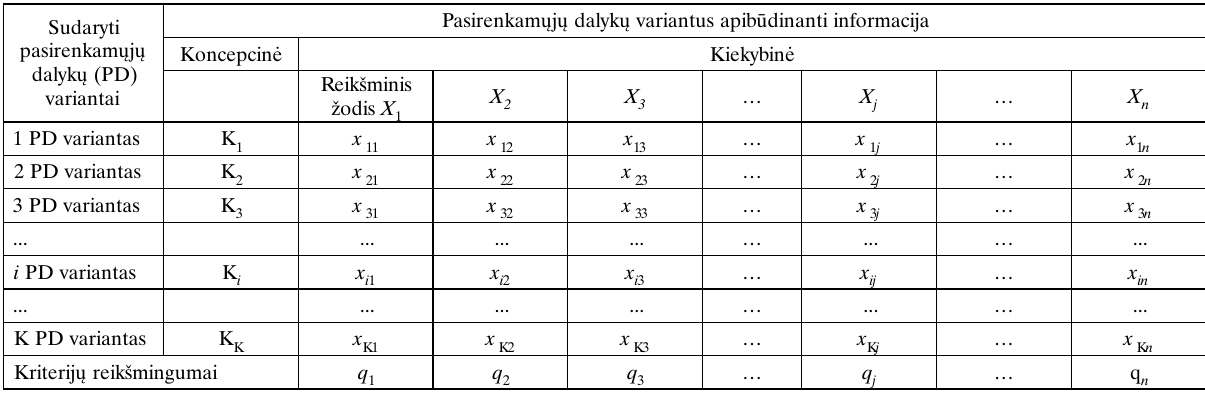
Table 2. Summary table of ready variants of optional subjects and their illustrative information for decision making ityraduS